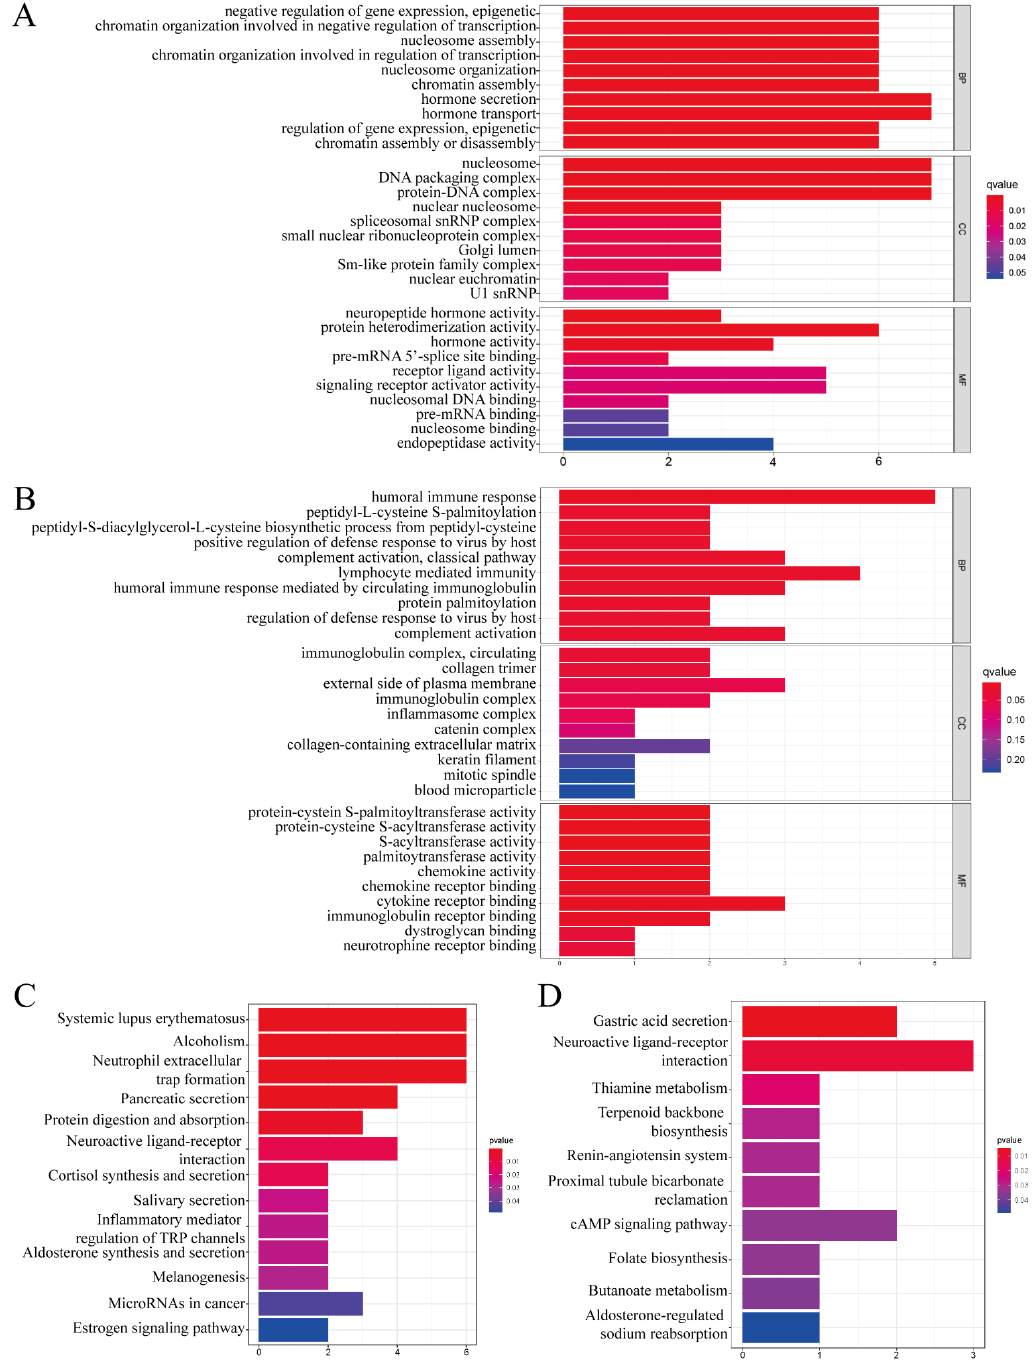
Figure 7. Gene enrichment analysis in the TCGA and ICGC cohorts. ( A ) Go annotation analysis in the TCGA cohort. ( B ) Go annotation analysis in the ICGC cohort. ( C ) KEGG annotation analysis in the TCGA cohort. ( D ) KEGG annotation analysis in the ICGC